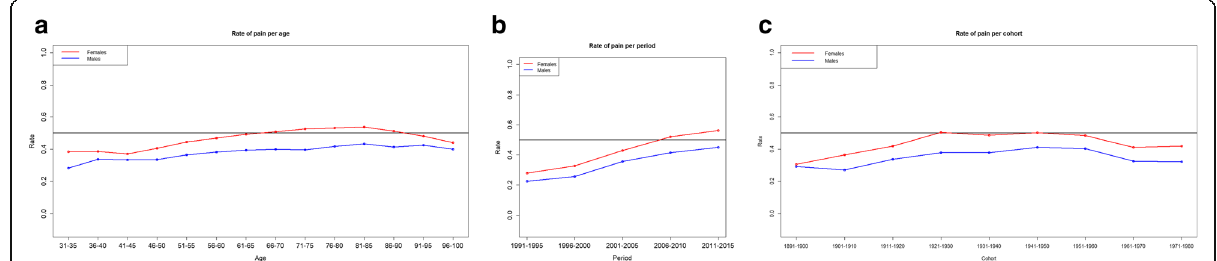
Fig. 1 Observed rate of pain in males and females by age, period and cohort . a : pain rates by age. b : pain rates by period. c : pain rate by cohort. Note. The dark central line indicates rate = 0.5